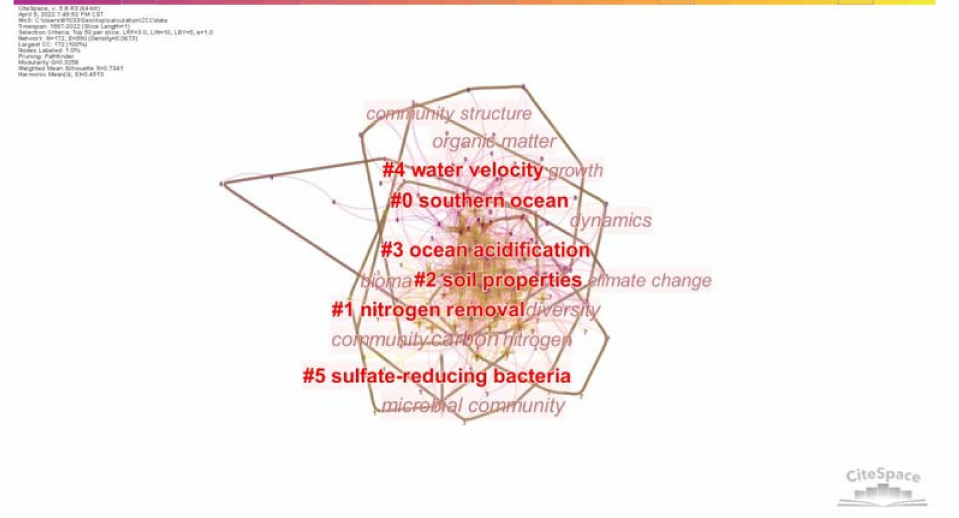
Figure 10. Cocitation network and clusters of the papers on ZCC during 1997–2022. Table 11. List of cited clusters and number of records